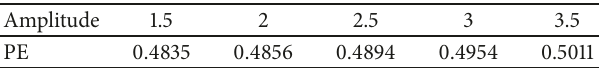
Table 4: The permutation entropy values corresponding to different amplitude of impulse